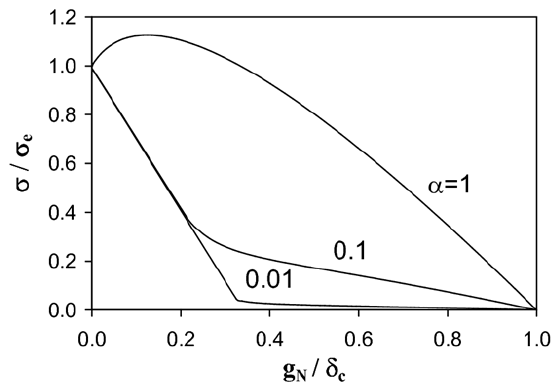
Figure 3: Shape of the Mode I nonlocal CZM as a function of  .